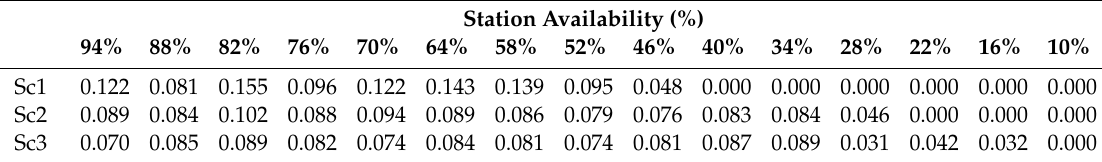
Table 9. The ranking of each CS after the operation of the AHP for the three scenarios. Station Availability